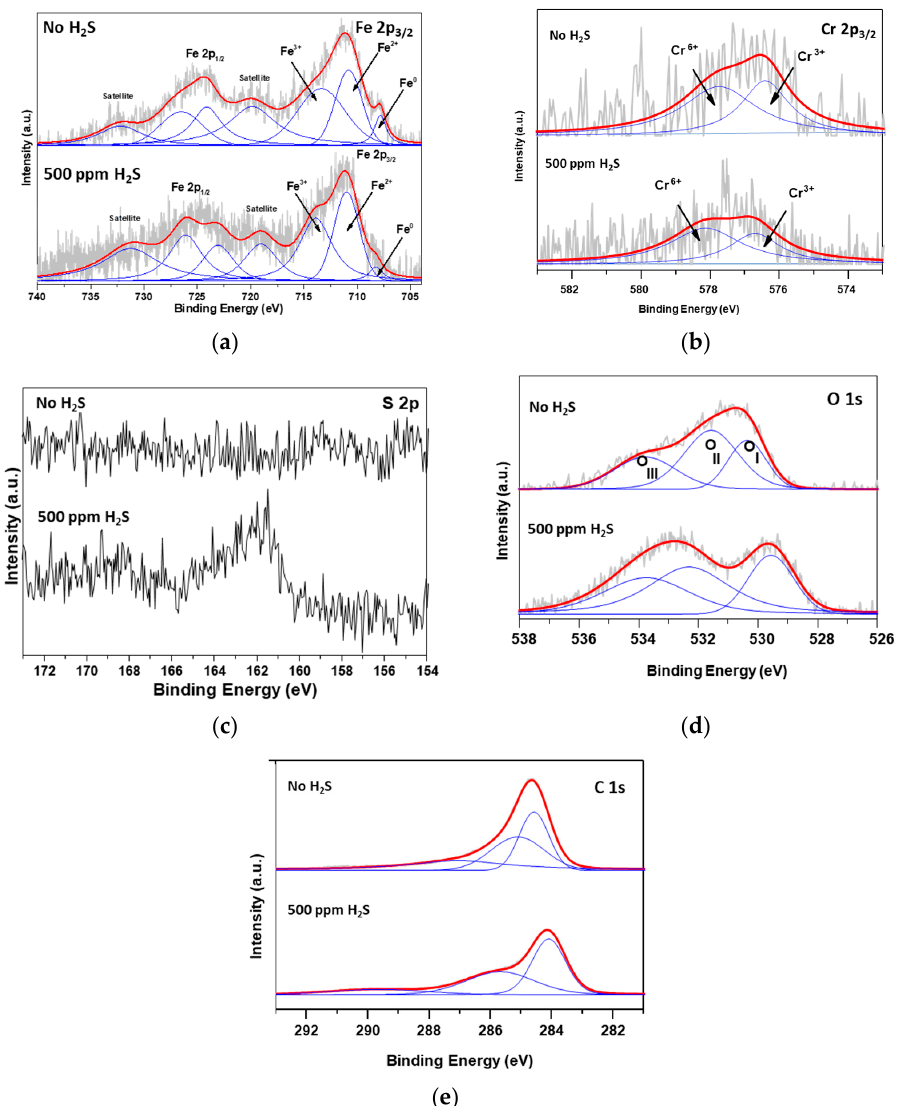
Figure 8. XPS spectra of the FeCr catalysts after reacting with the CO/CH 4 mixture with and without 500 ppmv H 2 S: ( a ) Fe 2p 3/2 spectra, ( b ) Cr 2p 3/2 spectra, ( c ) O 1s spectra, ( d ) C 1s spectra, and ( e ) S 2p spectra.